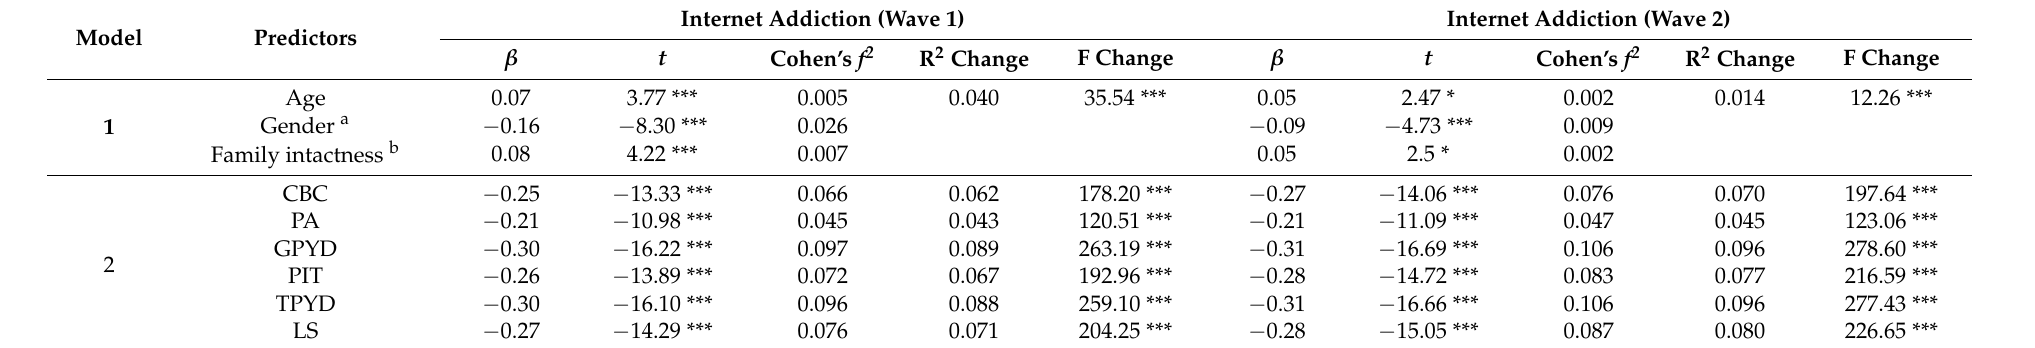
Table 3. Cross-sectional regression analyses for Internet